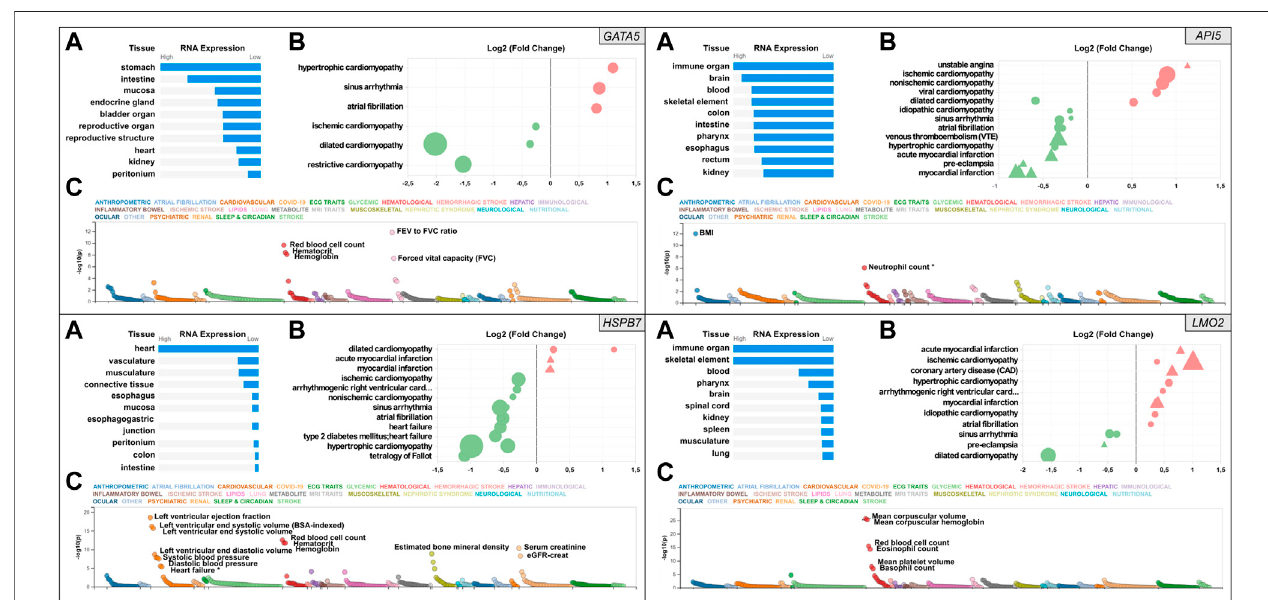
FIGURE1| Snapshotoftheresultsfromthe insilico assessmentoftheheartfailurecandidategenes API5 (topright), HSPB7 (bottomleft), LMO2 (bottomright),and positivecontrolgene GATA5 (topleftpanel). (A) .Thetop10tissuesshowingexpressionbasedonRNAsequencingdatafromtheHumanProteinAtlas(HPA)andEMBL- EBI Expression Atlas as summarized by Open Targets Platform (https://www.targetvalidation.org). (B) . Gene expression changes in cardiovascular disease conditions basedonpubliclyavailabletranscriptomestudiesfrom NCBI GeneExpressionOmnibus(GEO). Diseaseconditionsareshown onthe Y -axisand log2foldchanges (vs.normalcontrols)onthe X -axis. Iconsarecolouredbydirectionofchange;redand greenrepresentup-and downregulation inthatdisease,respectively.Iconshapes representtissuetypesubjectedtotranscriptomics;circlesandtrianglesrepresentheartandblood,respectively.Finally,iconsizere fl ectsstatisticalsigni fi cance;thelarger the icon the lower the p -value. All fi ndings shown are signi fi cant (Adjusted p -value < 0.05). (C) . Common variant gene locus association data from 190 datasets and 251 traitsinCommon MetabolicDiseases Knowledge Portal(CMDKP).Traitsconsidered genome-wide signi fi cant( p -value ≤ 5×10 − 8 )arehighlighted(border-linesigni fi cant traits are marked with